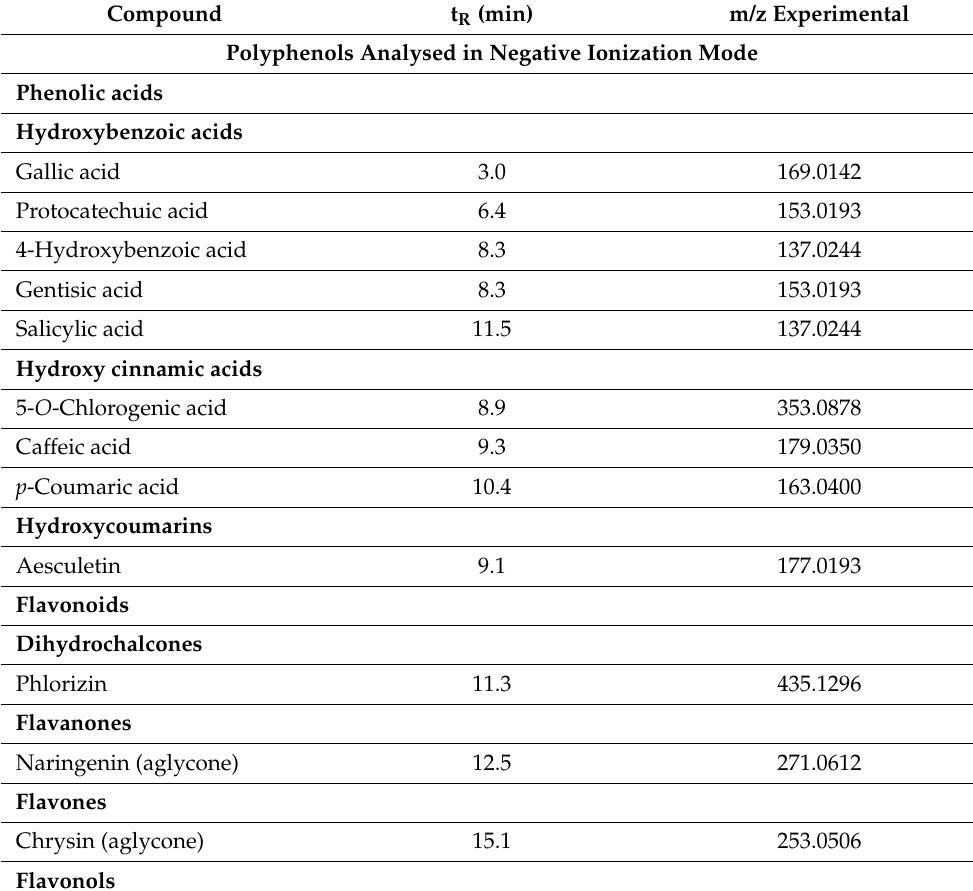
Table 2. Detected compounds in A. retinodes and A. mearnsii flowers by UHPLC/ESI-QTOF-MS. Compound t R